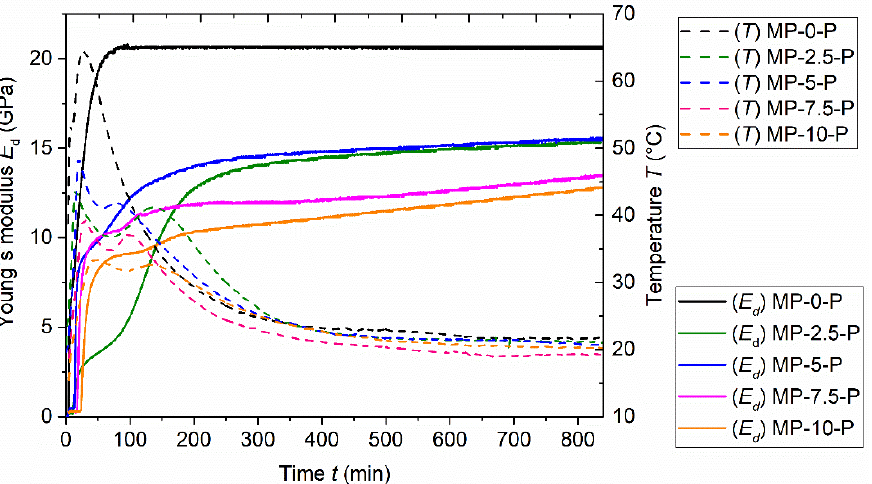
Figure 4. Development of the dynamic Young’s modulus of fresh MKPC pastes, duration 840 min.